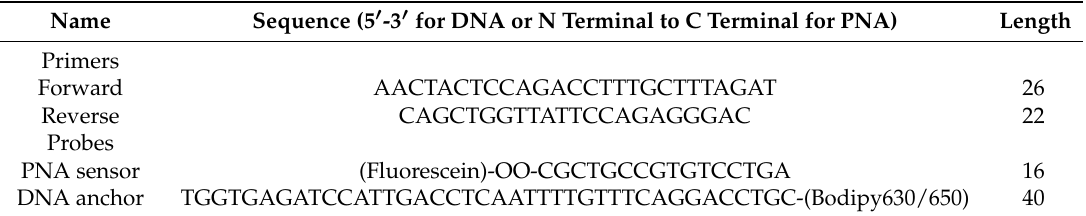
Table 2. Primers and probes used in this